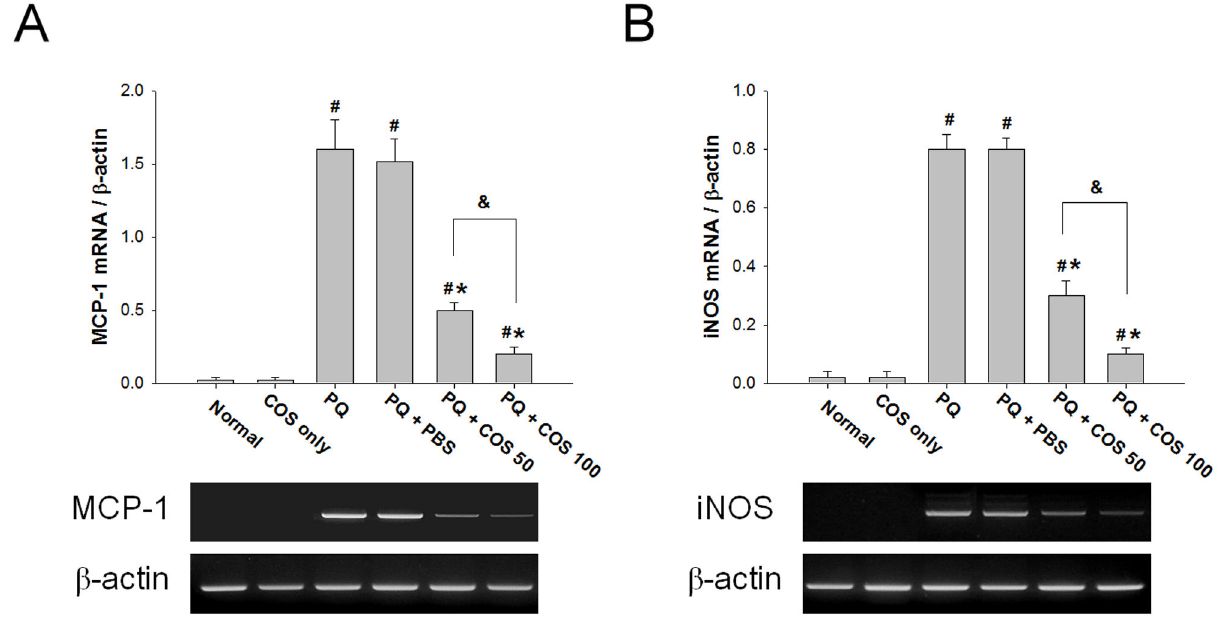
Figure 8. Effects of COS on the expression of MCP-1 and iNOS mRNA in RGC-5 cells. RGC-5 cells were stimulated with 0.5mM PQ and then treated with 50 μg/ml (low-dose) or 100 μg/ml (high-dose) COS for 12 hours. The mRNA expression levels of MCP-1 (A) and iNOS (B) were evaluated by semi-quantitative RT-PCR. The expression of MCP-1 and iNOS mRNA was significantly decreased in the low-dose and high-dose COS group than in the PQ only or PBS-treated group. In addition, the levels of iNOS and MCP-1 mRNA were more reduced in the high-dose than in the low-dose COS group. Data were expressed as mean ± SD. (* P < 0.05 compared with PQ only or PBS-treated group; # P < 0.05 compared with normal; & P < 0.05 by ANOVA test with post hoc Bonferroni test; N=3 in each group). doi: